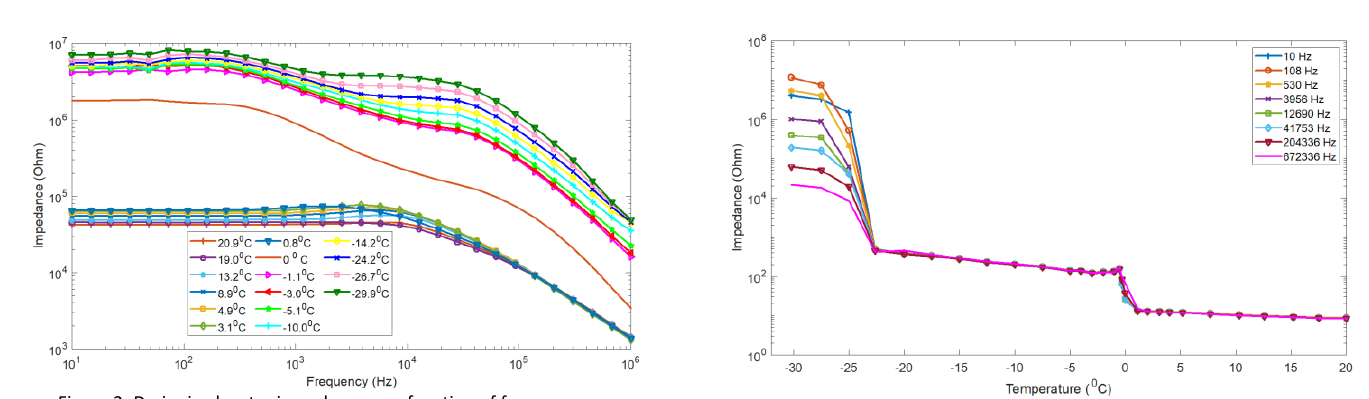
Figure 2: De-ionized water impedance as a function of frequency for different temperatures measured during freezing.